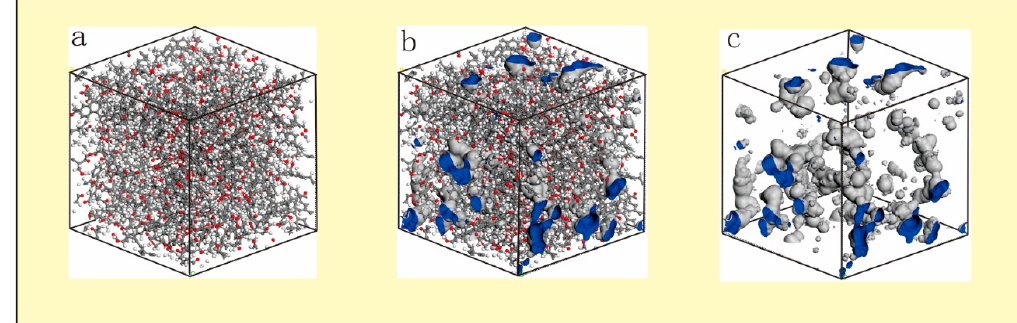
Figure 4. CO 2 probe molecular pore measurement. ( a ) three-dimensional structure ( b ) three- dimensional molecular structure and formed pores. ( c ) remove the pore structure of the atom.